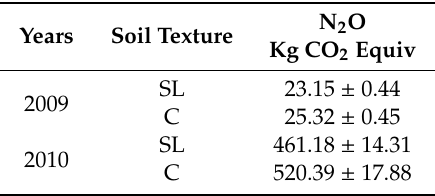
Table 3. Cumulative N 2 O fluxes expressed as the CO 2 equivalent.